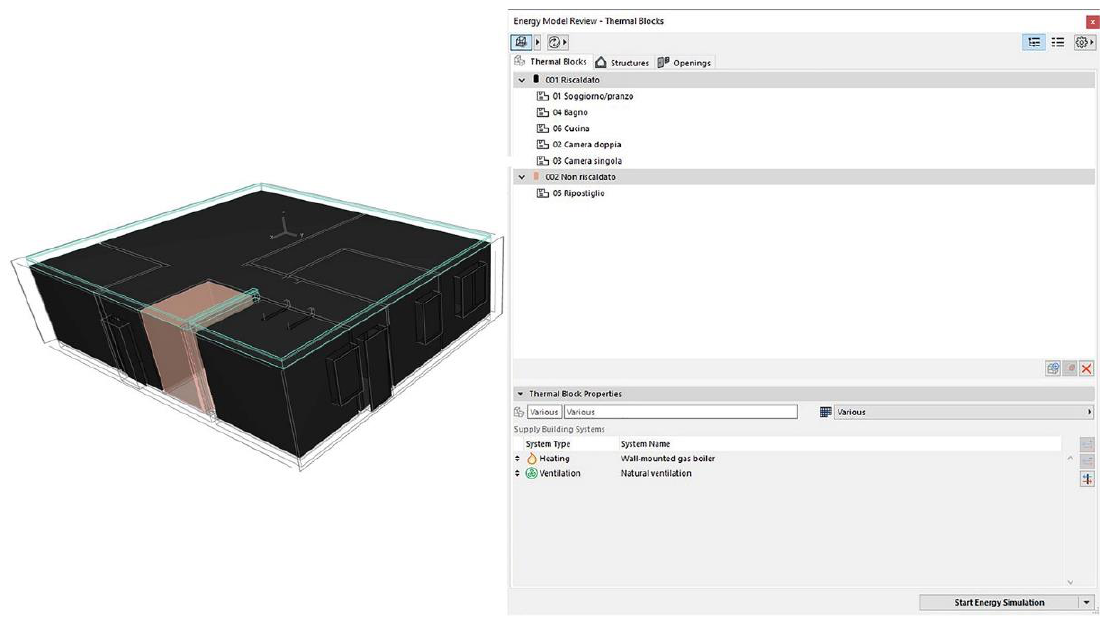
Figure 5. Screen of the thermal blocks window with 3D visualization of the selected zones.